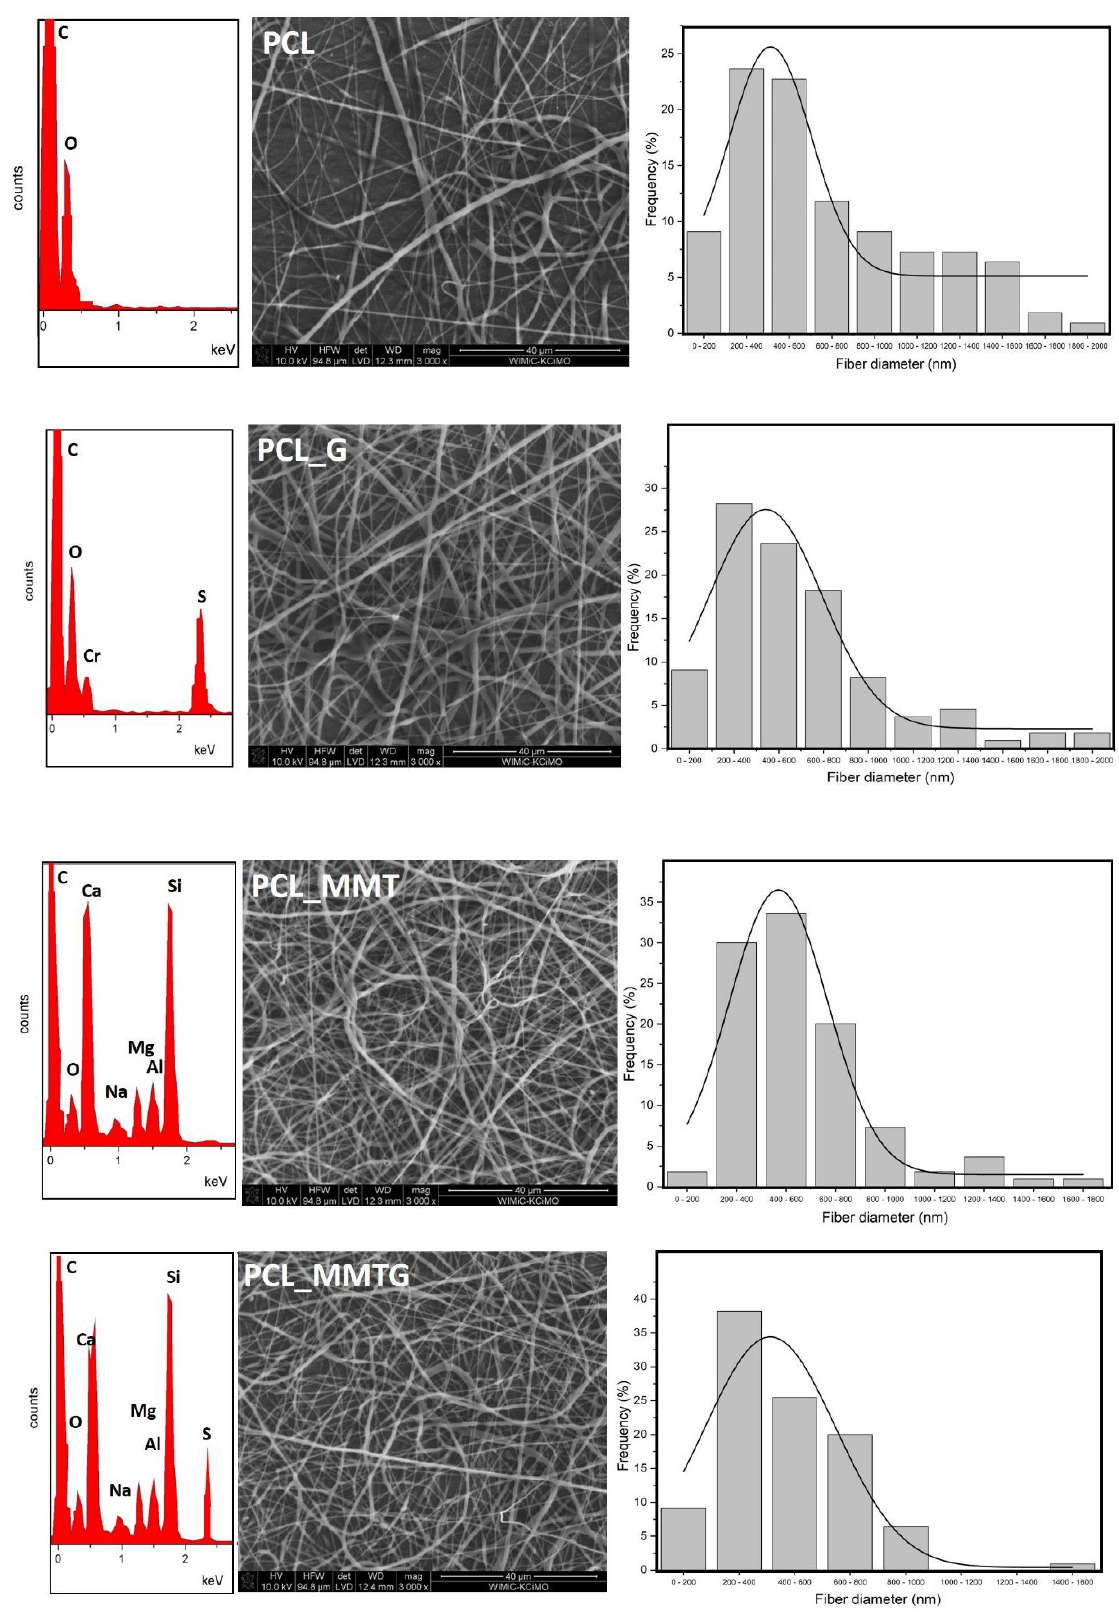
Figure 4. Microstructure of PCL_G, PCL_MMT and PCL_MMTG nanobiocomposite fibers and PCL polymer fibers with the fiber size distribution determined on the basis of SEM with EDS (average analysis of the observed microarea).